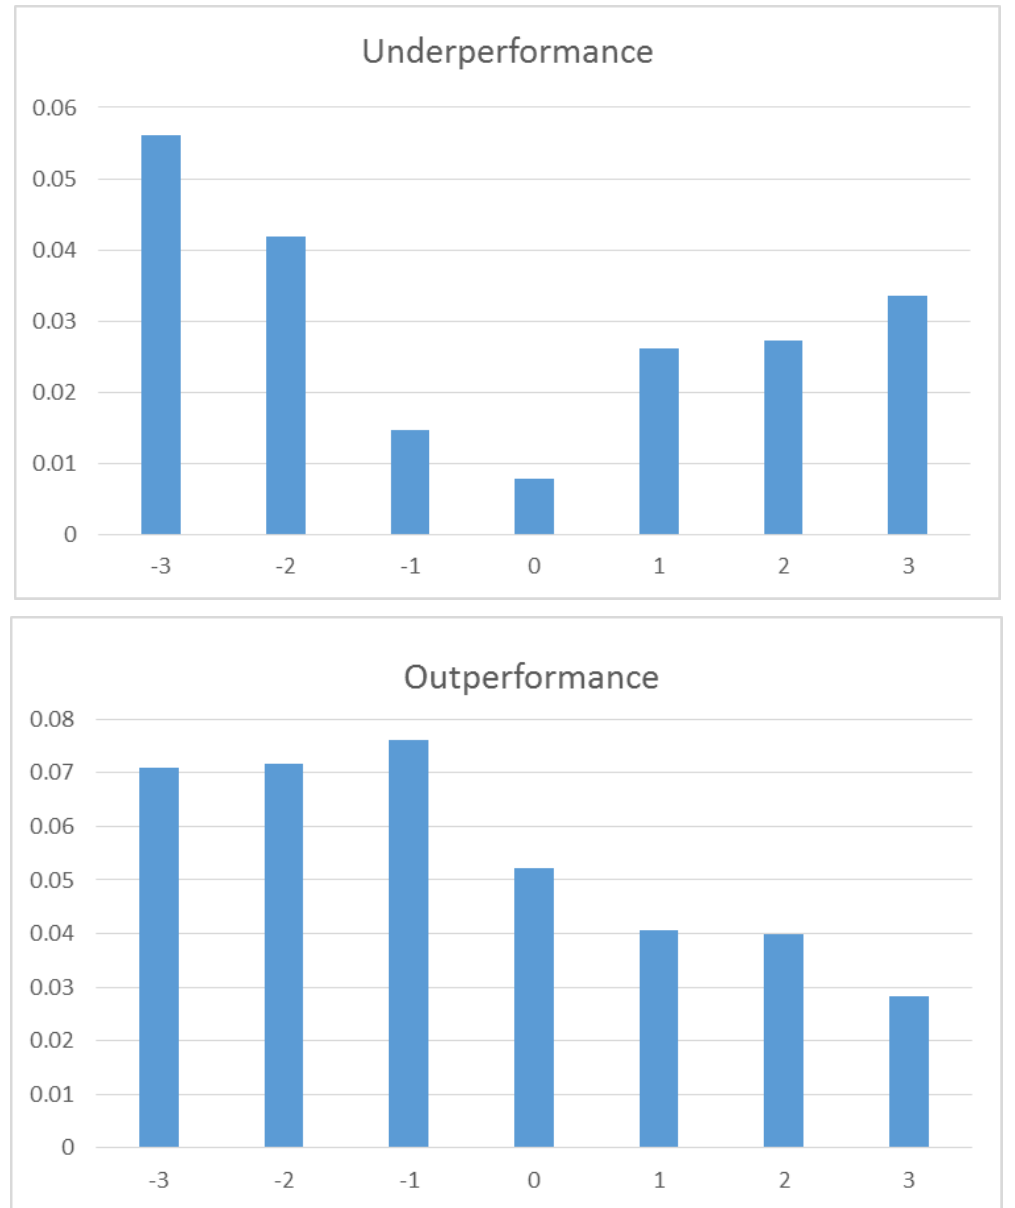
Figure 1. Industry-adjusted OROA surrounding forced CEO turnovers. This figure plots the industry-adjusted OROA for the out- and underperformance samples for the 7 years surrounding the management change, with Year 0 being the year of management transition. Underperformance (outperformance) sample includes firms with three-year preturnover CARs lower (higher) than that of the industry. OROA is adjusted by subtracting the median industry OROA using the 2-sic digit codes for matching.